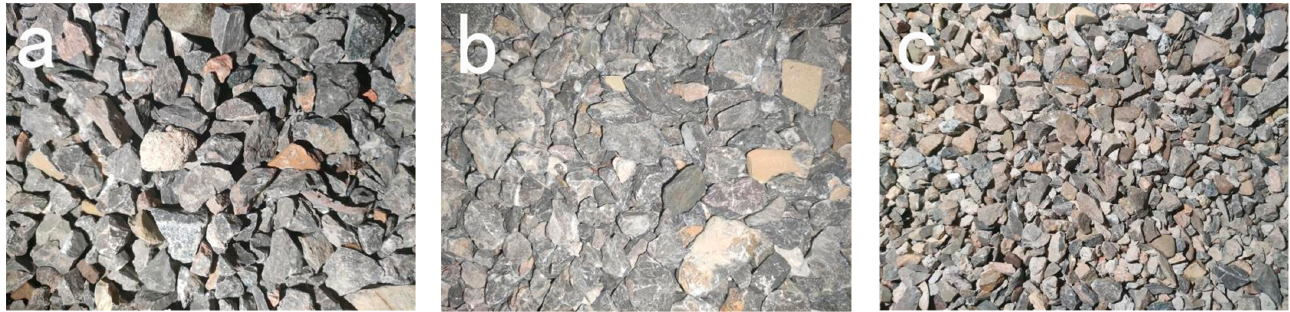
Table 4. Results of linear regression of the impact factor of the recycled aggregate and quality.